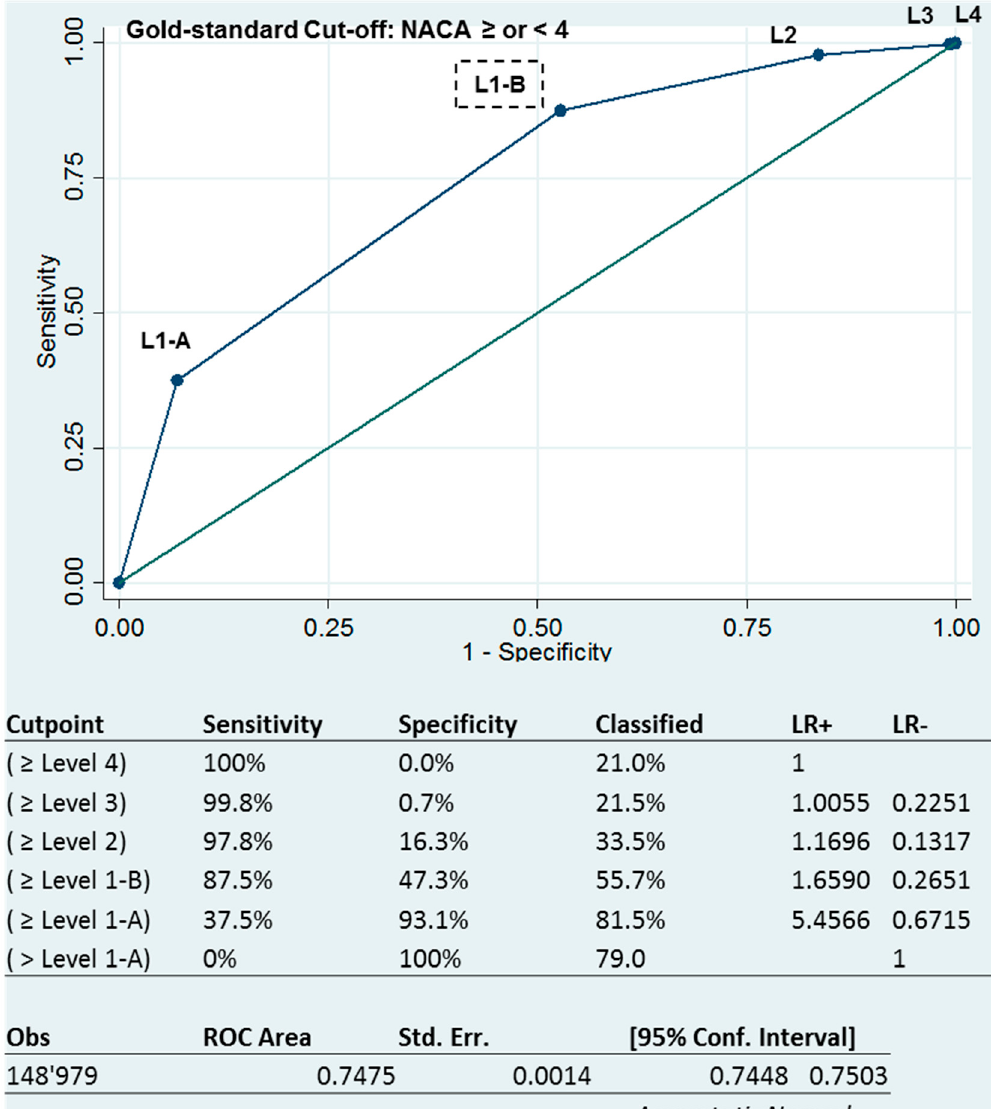
Figure 3. Receiver operating characteristic (ROC) curve of the dispatch levels to predict NACA ≥ 4.